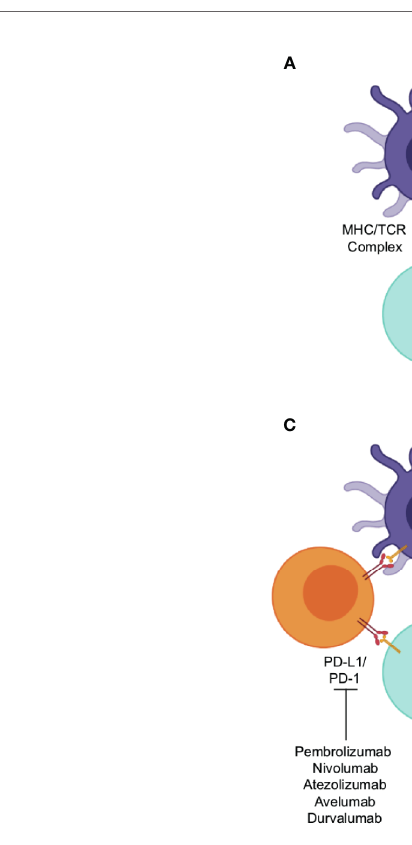
FIGURE 1 | Mechanisms of Treg-mediated immune evasion within the lung cancer immune microenvironment and strategies for therapeutic intervention. (A) Under physiologic conditions, an activated antigen-presenting cell (APC) will associate with an effector T-cell, presenting antigen peptide on an MHC molecule. This will associate with the T-cell receptor, which combined with additional stimuli such as co-stimulation mediated in part by association of the APC ’ s B7 and T-cell ’ s CD28, lead to T-cell activation and enhanced effector function. Regulatory T-cells (Tregs) suppress effector T-cell activation through a variety of mechanisms. (B) One such mechanism is the association of Treg ’ s cytotoxic T-lymphocyte-associated protein 4 (CTLA-4) with the APC ’ s B7, outcompeting the effector T-cell for the co- stimulation signal thereby leading to anergy. This serves as the rationale for the use of anti-CTLA-4 antibodies such as ipilimumab and tremelimumab, which function to block this interaction, thereby enhancing anti-tumor immune responses. (C) Both APCs and effector T-cells can express programmed cell death protein 1 (PD-1) on their surface. Treg expressed PD-1 ligand 1 (PD-L1) can associate with PD-1, leading to reduced co-stimulation by the APC or functional inactivation of the effector T-cell. This association is interrupted by antibodies against PD-1 (pembrolizumab and nivolumab) or PD-L1 (e.g., atezolizumab, avelumab, and durvalumab), and this strategy is now considered the cornerstone of lung cancer therapy. (D) Tregs traf fi c into tumor tissues largely by following gradients of CCR4 ligands such as CCL17 and CCL22. There, they produce a variety of suppressive cytokines, namely interleukin 10 (IL-10) and transforming growth factor b (TGF b ). These both can limit effector T-cell responses, and facilitate tumor escape from immune surveillance. This also provides several potential opportunities for therapeutic intervention including: anti-CCR4 antibodies such as mogamulizumab (KW-0761) to block Treg traf fi cking, anti-CD25 antibodies or chemotherapy agents, cyclophosphamide and docetaxel, to deplete Tregs, or anti-TGF b agents such as galunisertib or other targeted therapies to block the immune suppressive actions of Treg-derived cytokines within the lung tumor